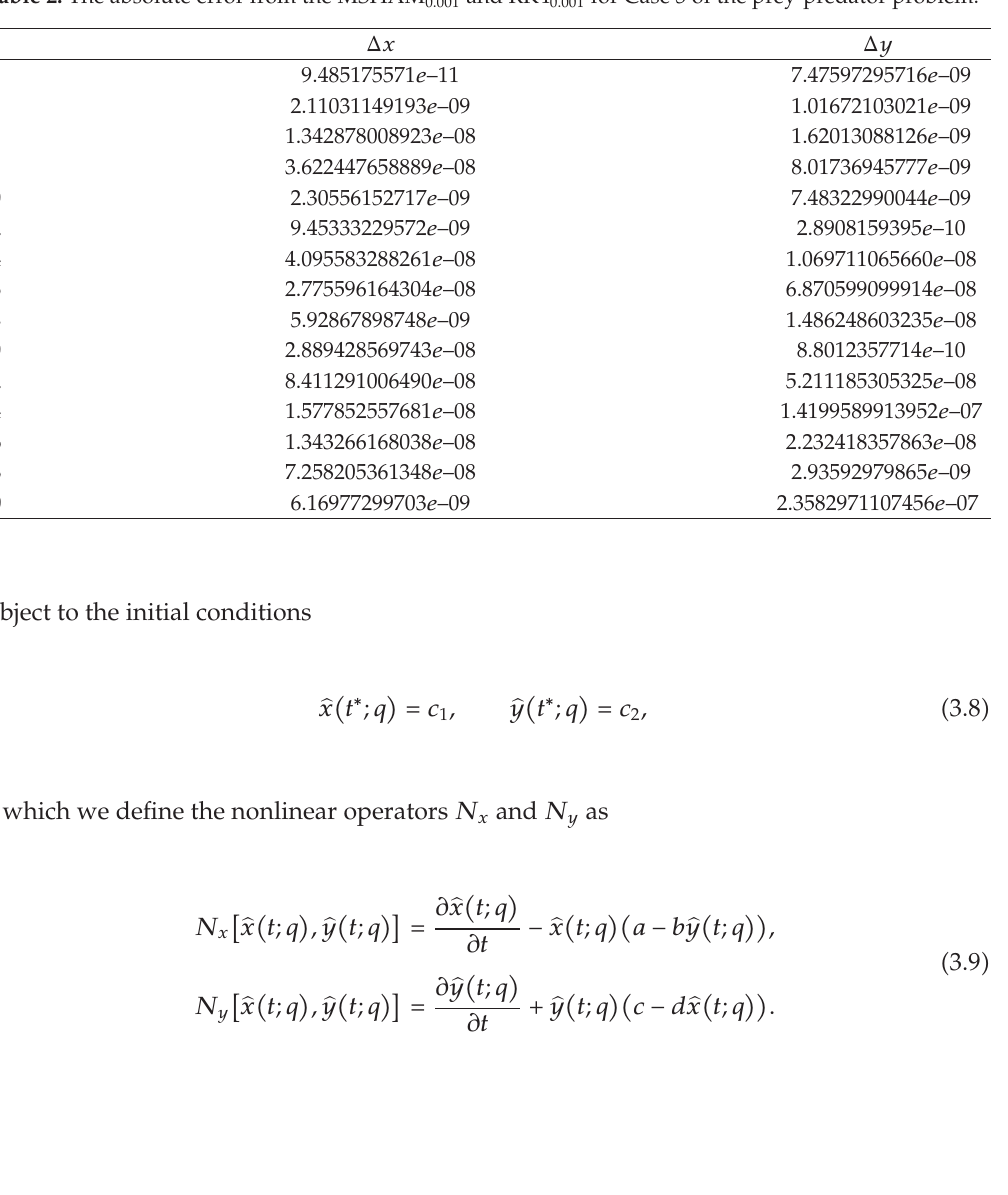
Table 2: The absolute error from the MSHAM 0 . 001 and RK4 0 . 001 for Case 5 of the prey-predator